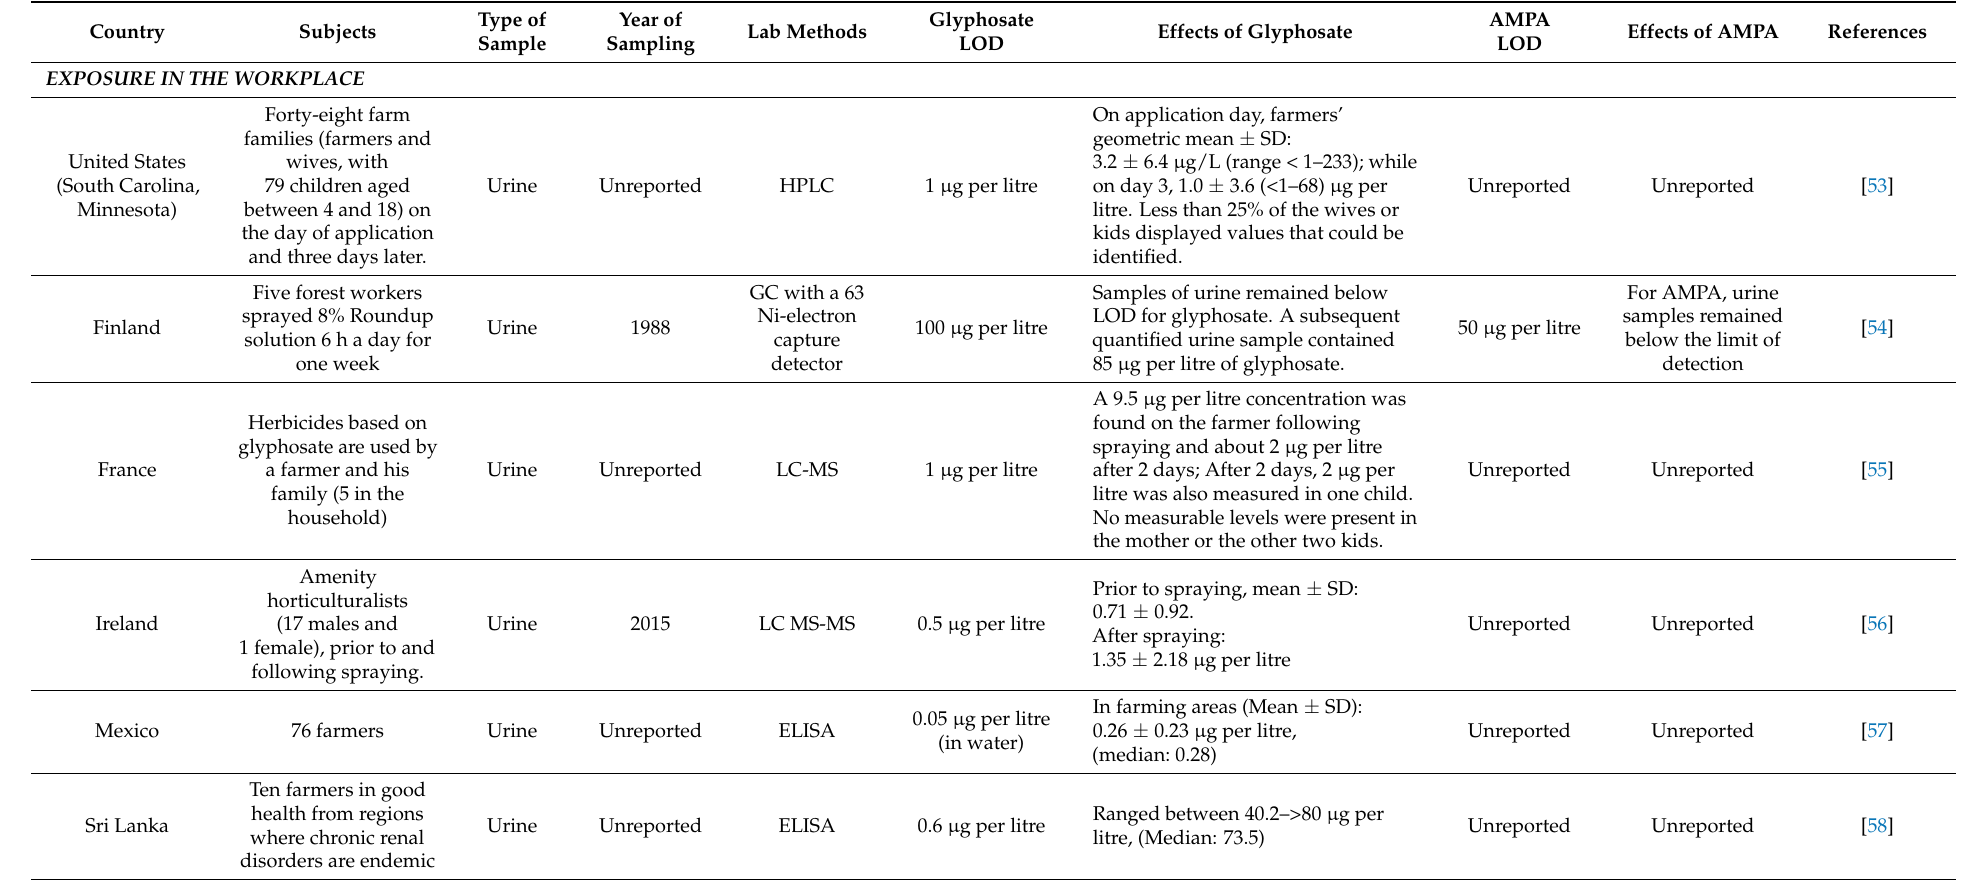
Table 1. Description of glyphosate and AMPA studies in several